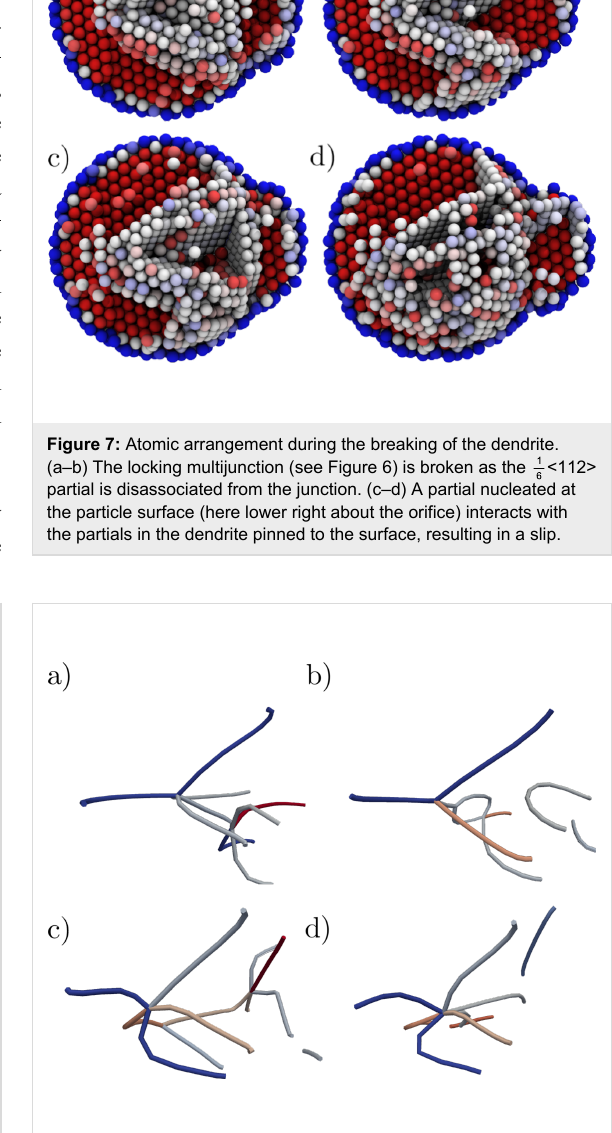
Figure 6: A dislocation multijunction blocking the dislocation mobility and nucleation in the system. Dislocations end at the right side of the figure on the particle surface, and the Shockley partial on the left connects to the other dislocations in the particle. Colouring by the length of the Burgers vectors, red | <312>|, grey | <112>|, and blue | <110>|